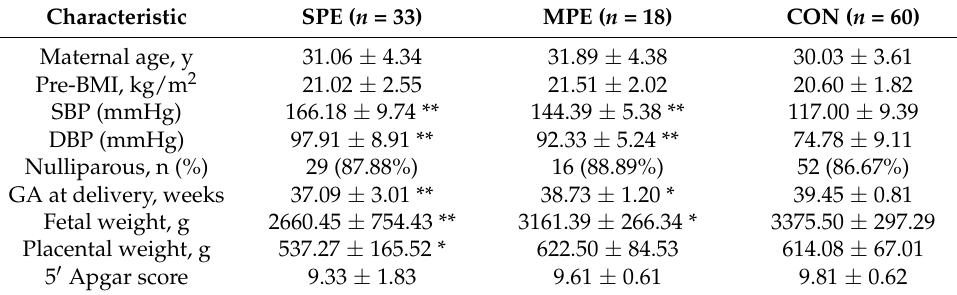
Table 1. Demographic characteristics of the participants.